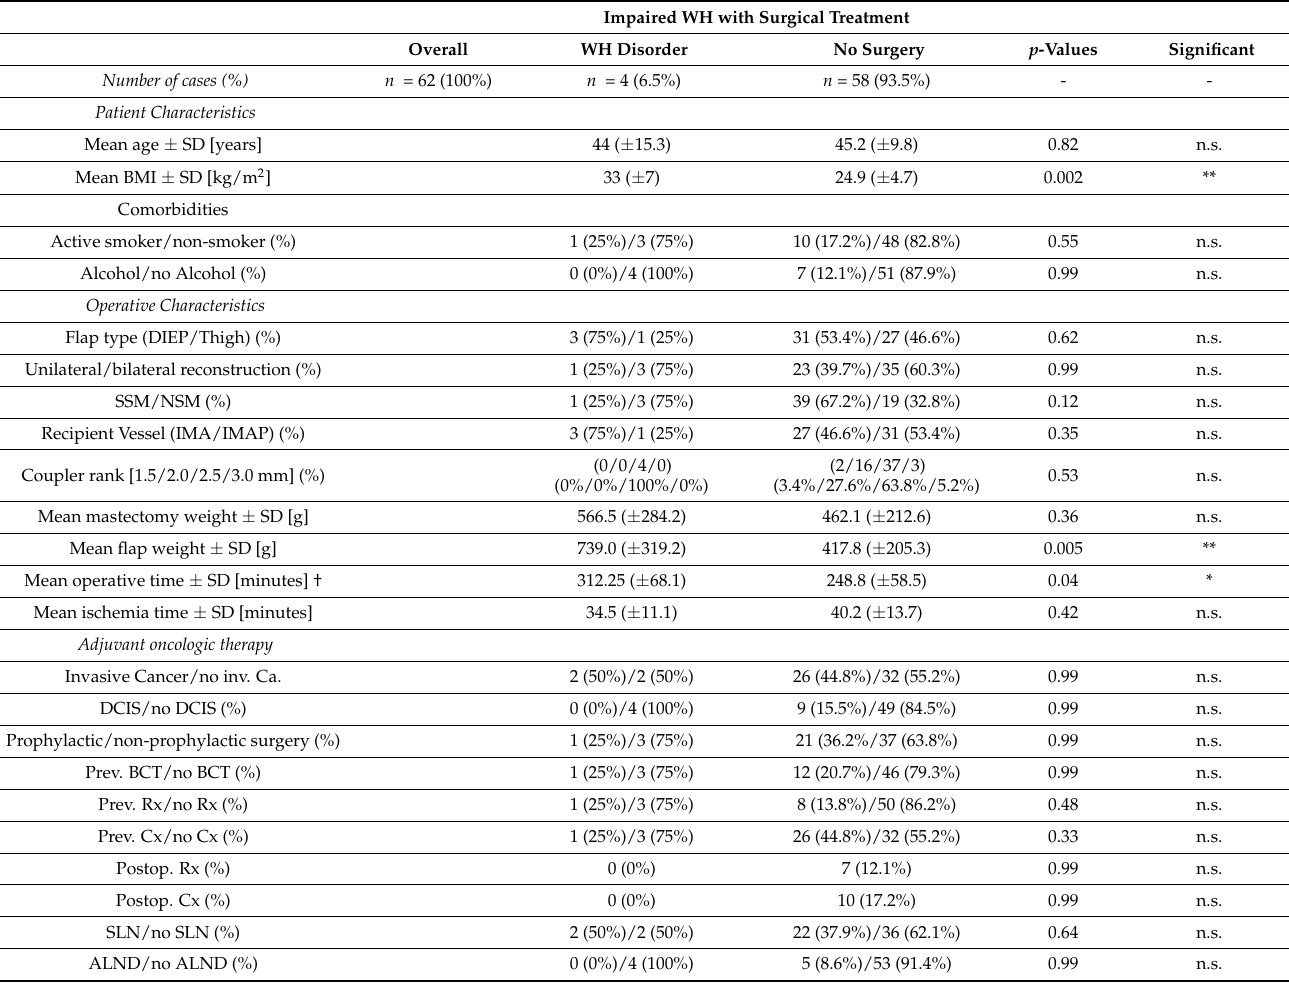
Table 6. Univariate analysis of risk factors between cases with impaired wound healing treated surgically (major complications) and cases without wound healing